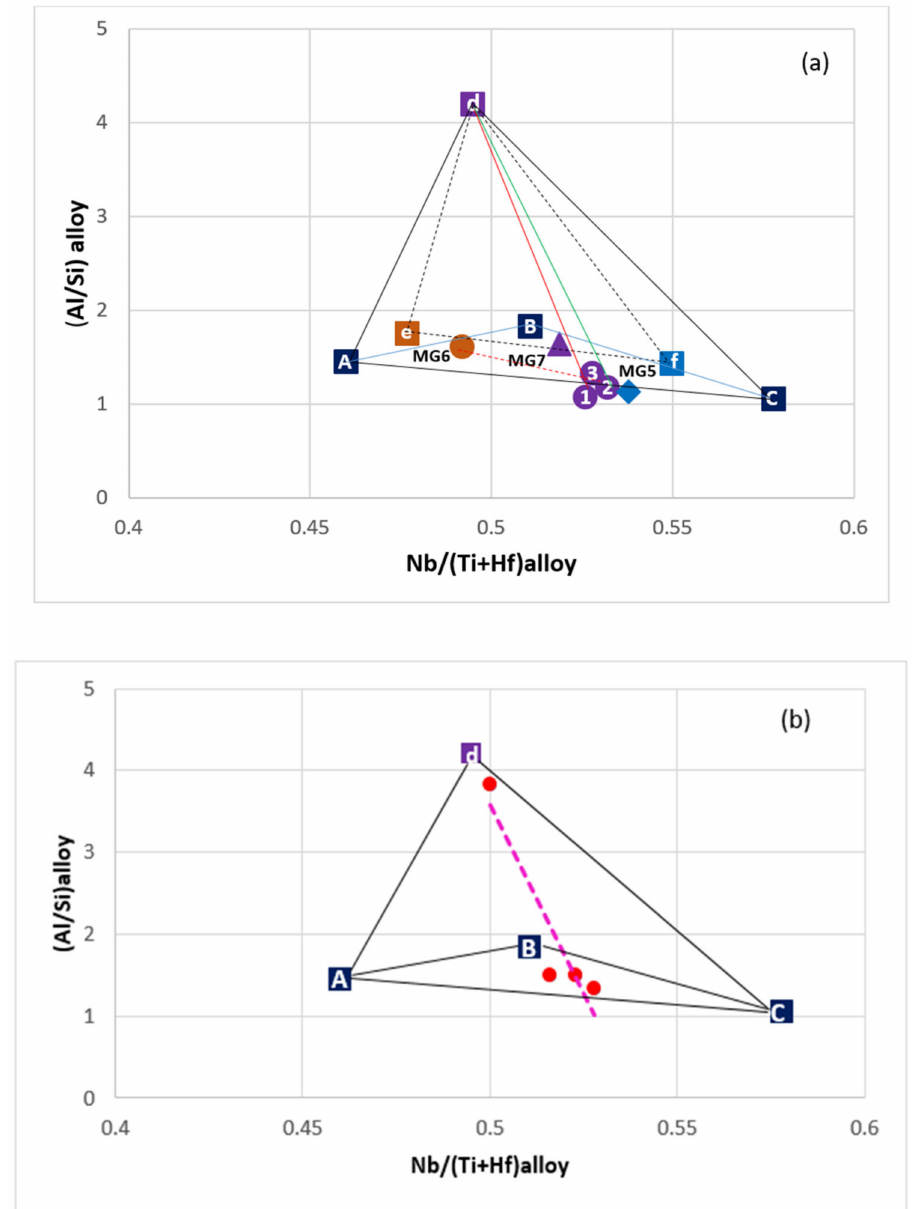
Figure 13. (Al/Si) alloy versus [Nb/(Ti + Hf)] alloy maps for Nb-Ti-Si-Al-Hf alloys (see text). ( a ) The alloys Nb 1.45 Si 2.7 Ti 2.25 Al 3.25 Hf 0.35 (MG5), Nb 1.35 Si 2.3 Ti 2.3 Al 3.7 Hf 0.35 (MG6) and Nb 1.3 Si 2.4 Ti 2.4 Al 3.5 Hf 0.4 (MG7) are shown in the map for their actual compositions. Brown MG6, purple MG7 and blue MG5. The triangle def is defined by the highest (Al/Si) alloy values and corresponding Nb/(Ti + Hf) alloy ratios due to macrosegregation in the alloys MG5, MG6 and MG7 (the strongest segregating elements in these alloys were Al and Si). The numbers 1 to 3 are for the top (1), bulk (2) and zone B (3), and d is for the zone A of the alloy Nb 1.3 Si 2.4 Ti 2.4 Al 3.5 Hf 0.4 (MG7) [3]. For the triangle ACd see text. ( b ) shows the bond coat alloys (red circles) in the ACd